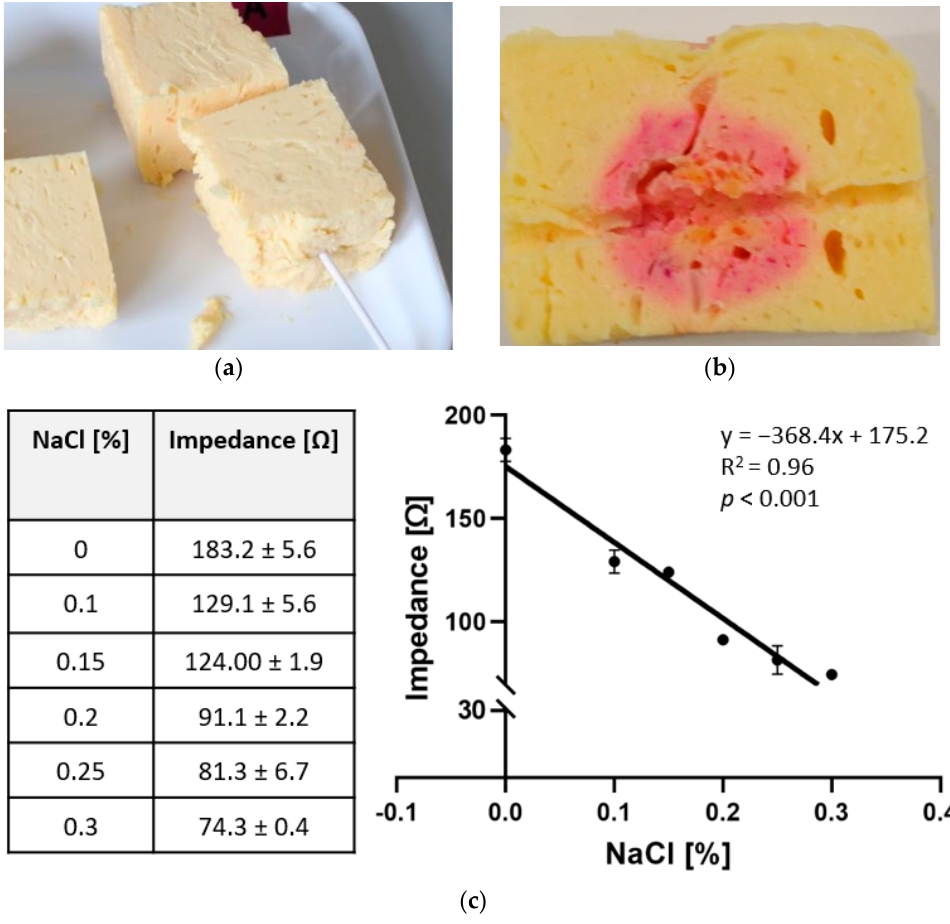
Figure 3. Evaluation of established surrogate. ( a ) Experimental setup with inserted RFA instrument into one piece of surrogate; ( b ) ablation outcome with color change from thermochromic ink after the block was cut along the probe channel; and ( c ) calculated mean impedance values for each sodium chloride concentration and linear fit of impedance as a function of sodium chloride.